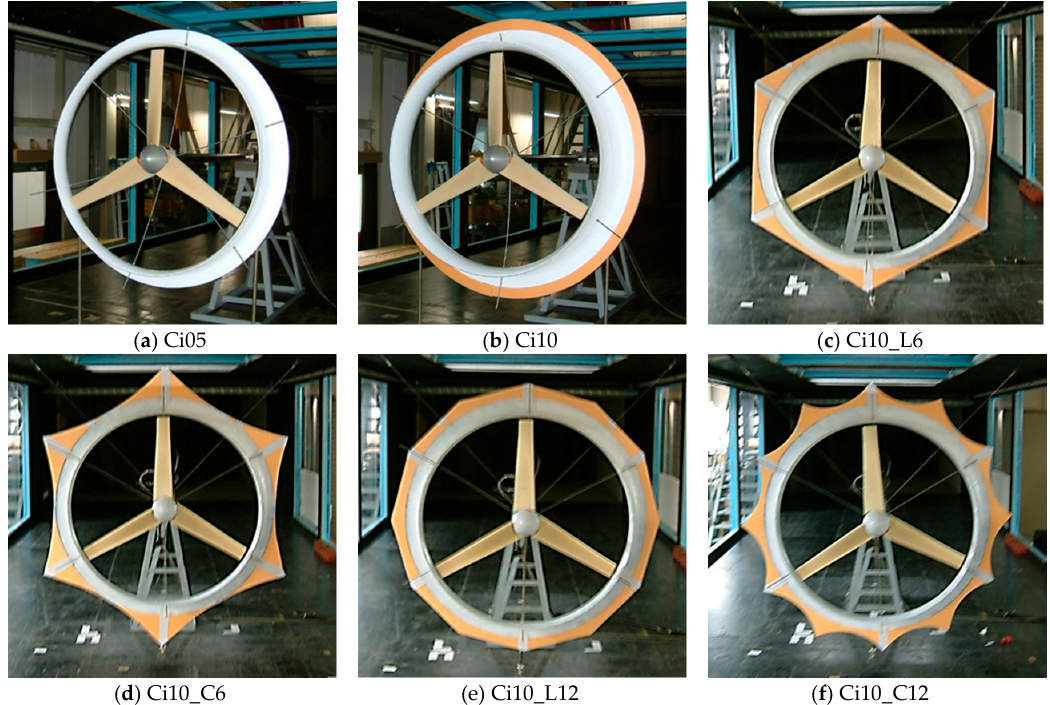
Figure 6. The various WLT brim shapes tested in the wind tunnel experiments: ( a ) Ci05 (circular brim, h = 0.05 D throat ); ( b ) Ci10 (circular brim, h = 0.10 D throat ); ( c ) Ci10_L6 (hexagon brim with straight sides, h = 0.10 D throat ); ( d ) Ci10_C6 (hexagon brim with curved sides, h = 0.10 D throat ); ( e ) Ci10_L12 (dodecagon